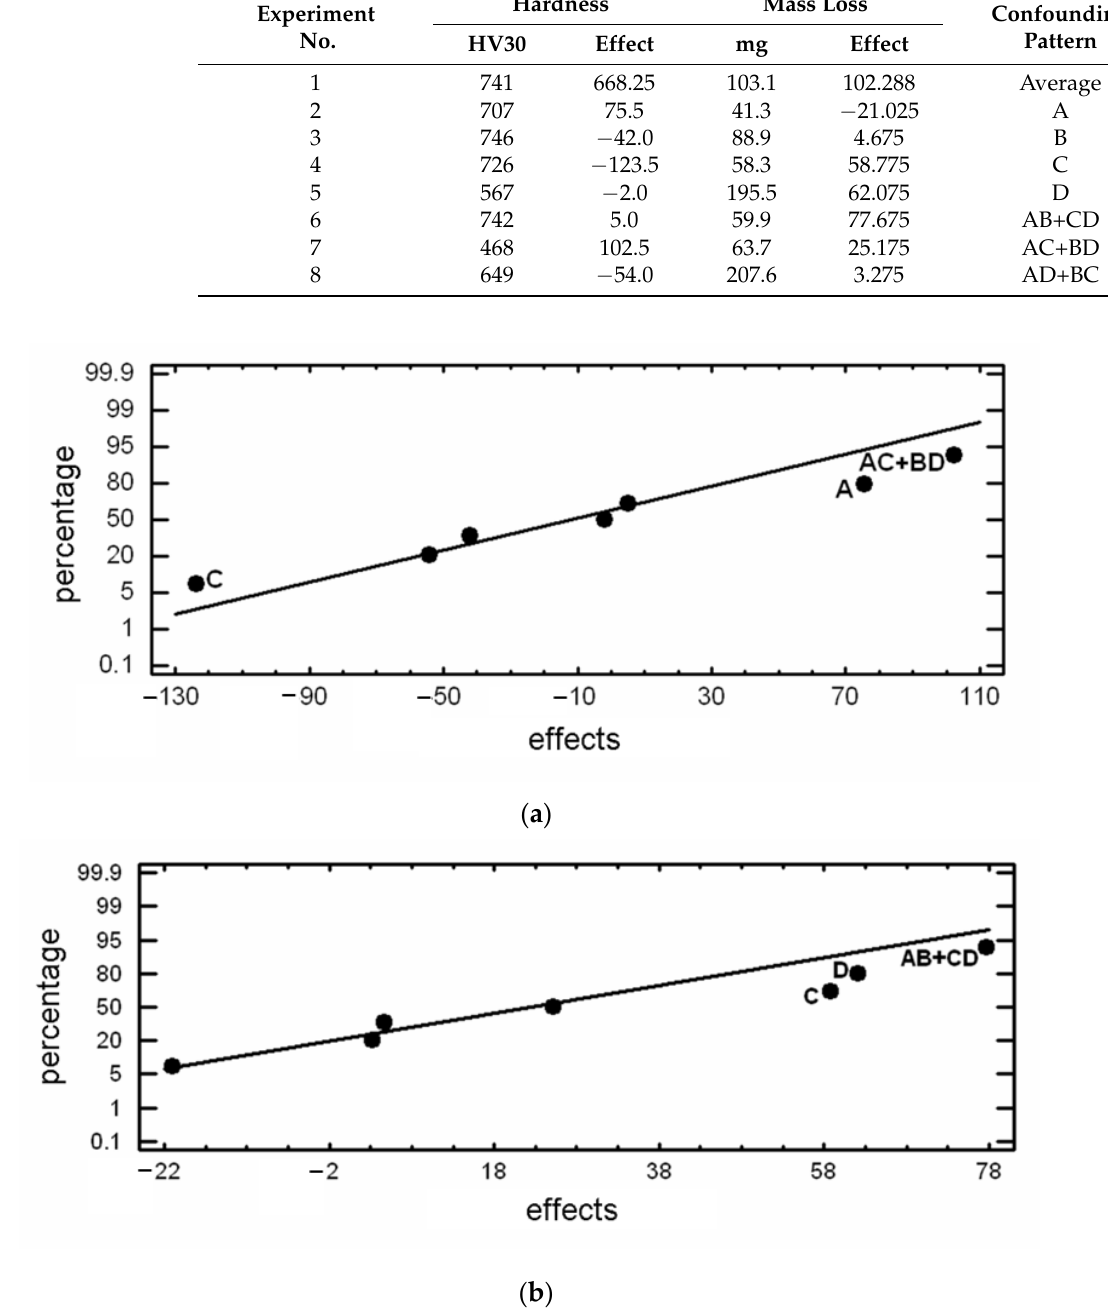
Figure 4. Normal probability plot showing the factors with significant effect on: ( a ) Vickers hardness (HV30), and ( b ) wear resistance measured by the weight loss of high-alloy treated white iron in a sliding test.